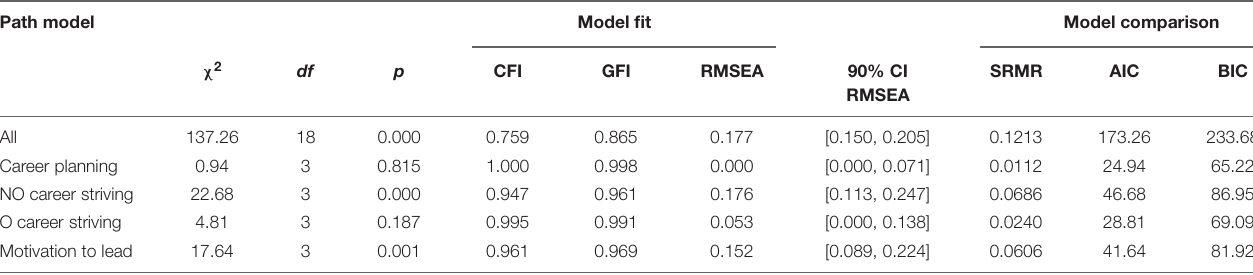
TABLE 2 | Model fit indices and model comparison for the path models in Study